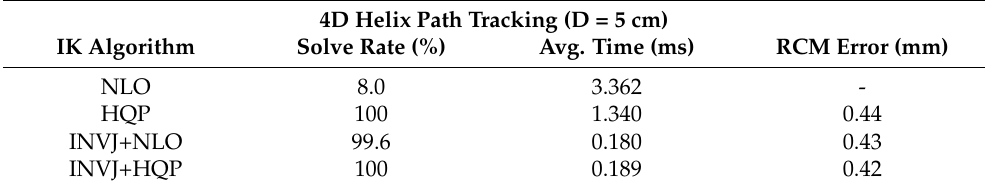
Table 8. Solve rate and solving time performance for a 6-DOF robotic endoscope holder tracking a 4D helix path (D = 5